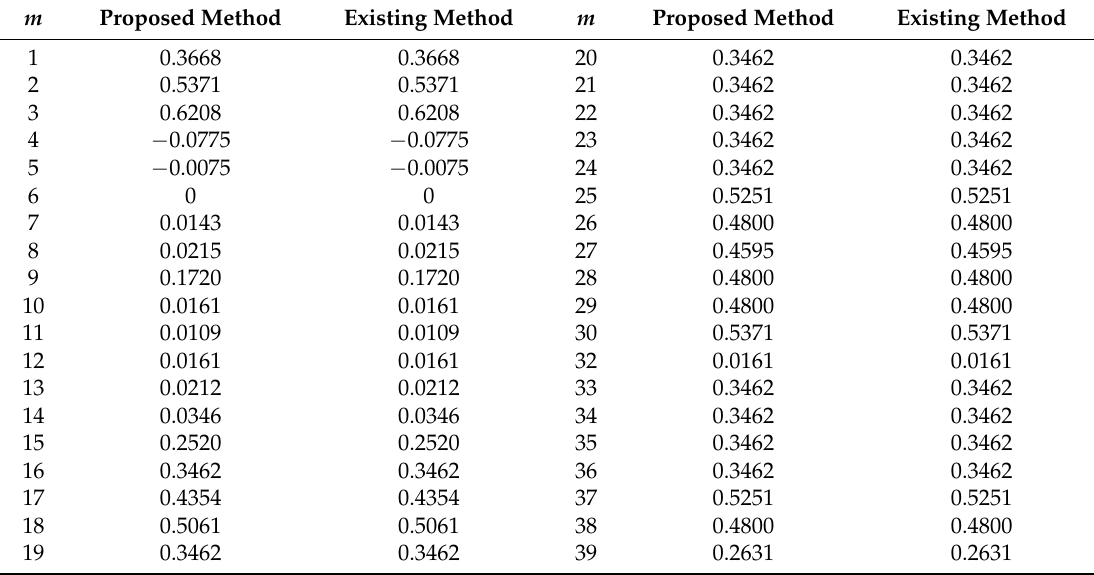
Table 3. HPCs obtained by the proposed method and the existing method under X TCSC1 = 0.0030 for scenario